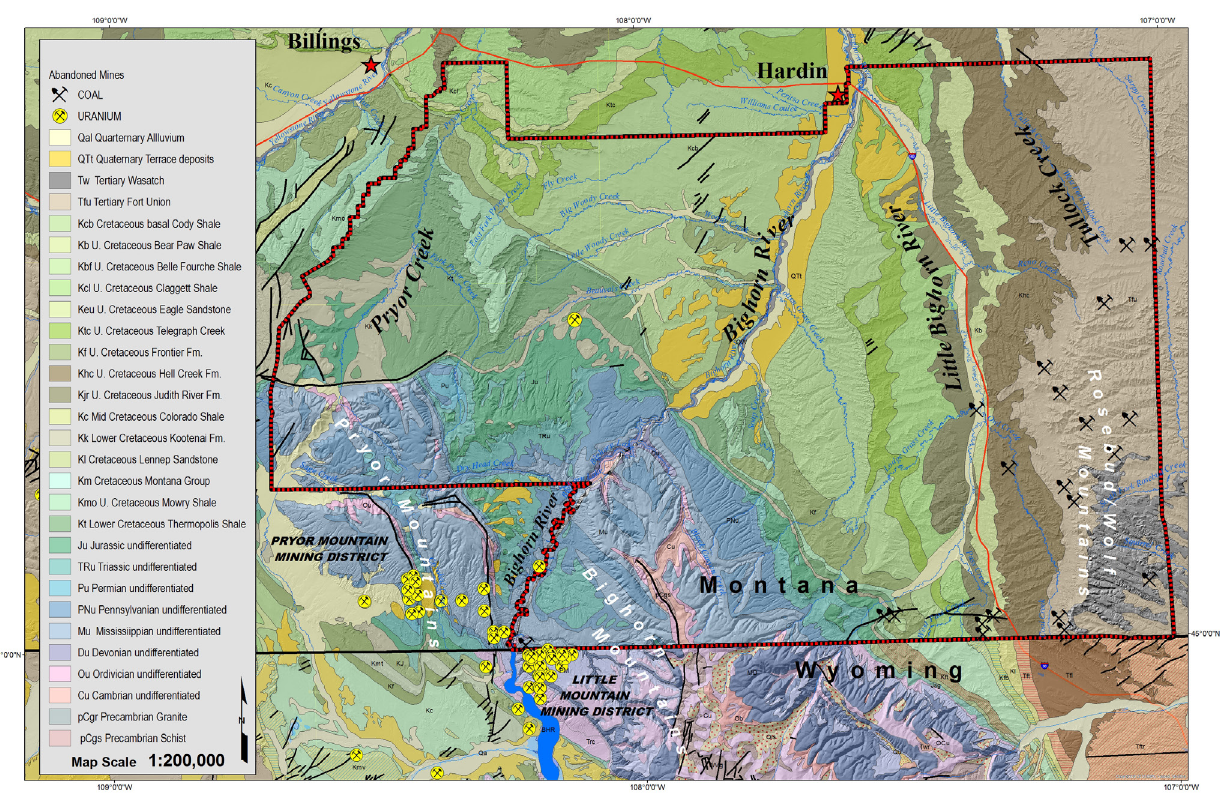
Figure 3. Geologic map of the reservation, showing locations of old uranium